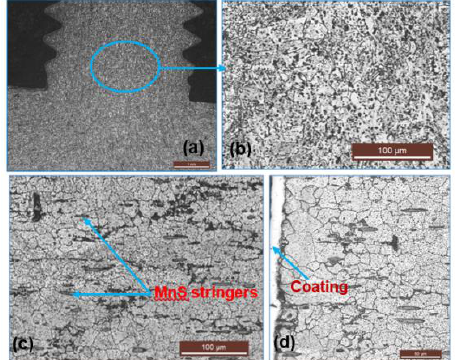
Figure 12: (a) Cross-sectional etched optical micrograph of the plain washer, etchant: 2% nital, (b) EDS analysis of the base material for plain washer, (c) EDS analysis of the coating for plain washer.